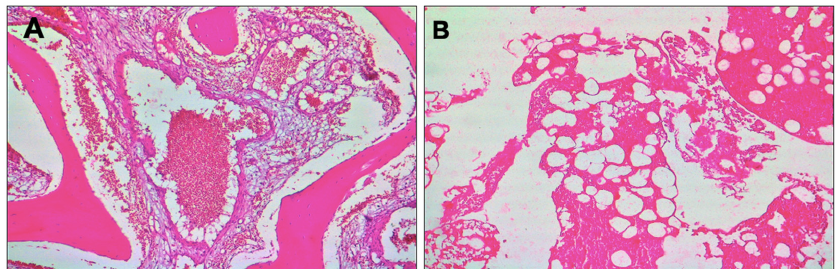
Figure 5. Microscopical images related to some details obtained during the histological investigation—hematoxylin and eosin (H&E) section: ( A ) Dilated blood vessel that replace the hematogenous marrow (×10 original magnification); ( B ) areas with hemorrhagic necrosis located in an angiolipomatous formation (H&E, ×4 original magnification).